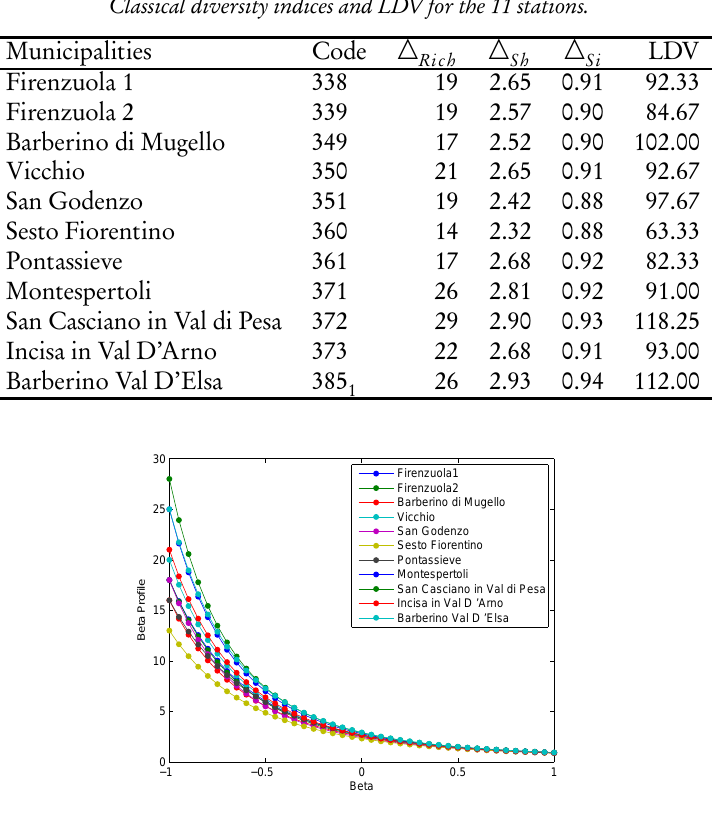
) for the 11 sites in the province of β